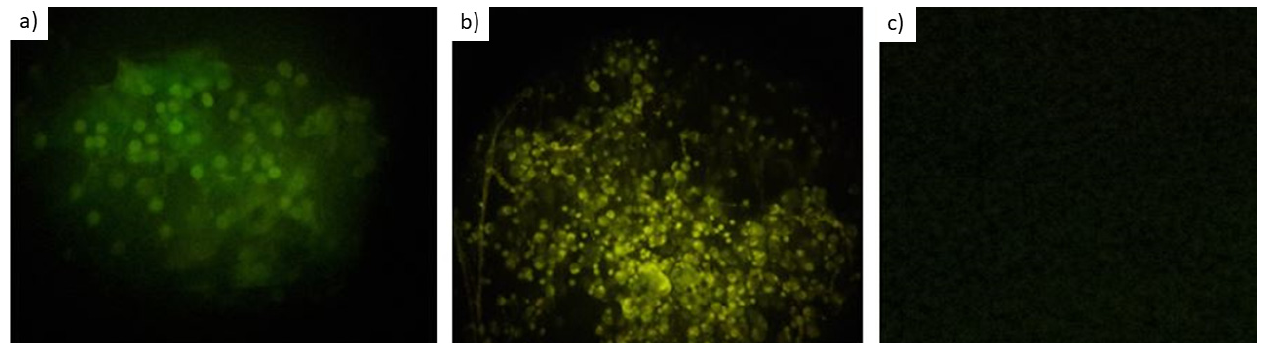
Table 2. Comparison of in-house real-time PCR results and FISH staining results with respiratory secretion. Real-time PCR was used as the reference standard.